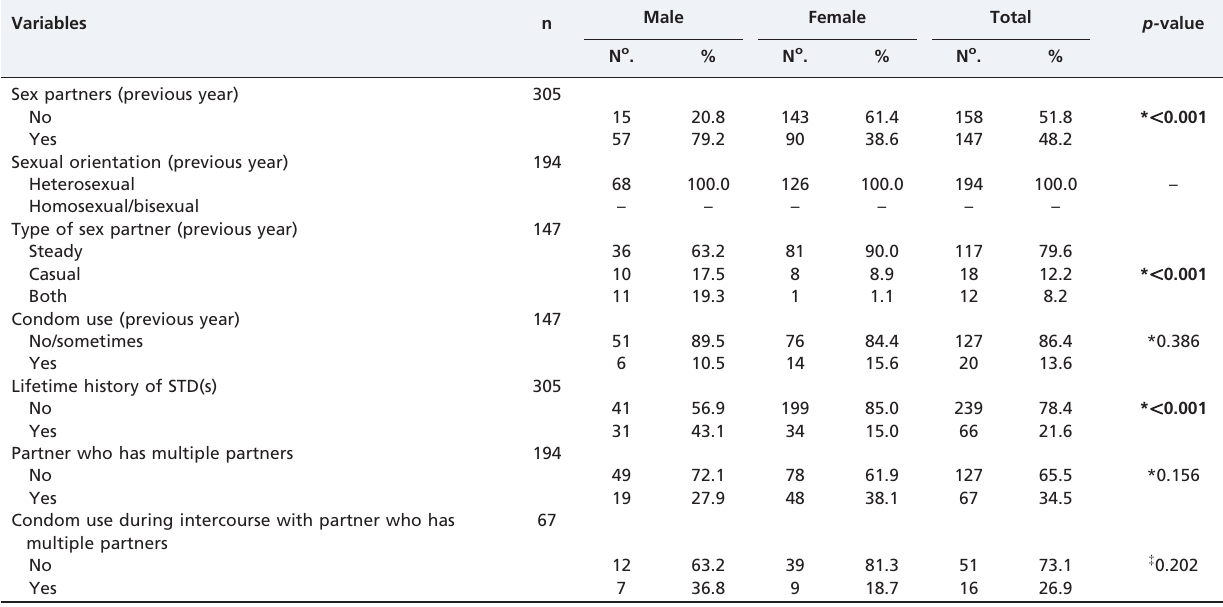
Table 4 - Sexual behavior variables investigated in elderly individuals attending senior community centers. Campo Grande, MS, Brazil,